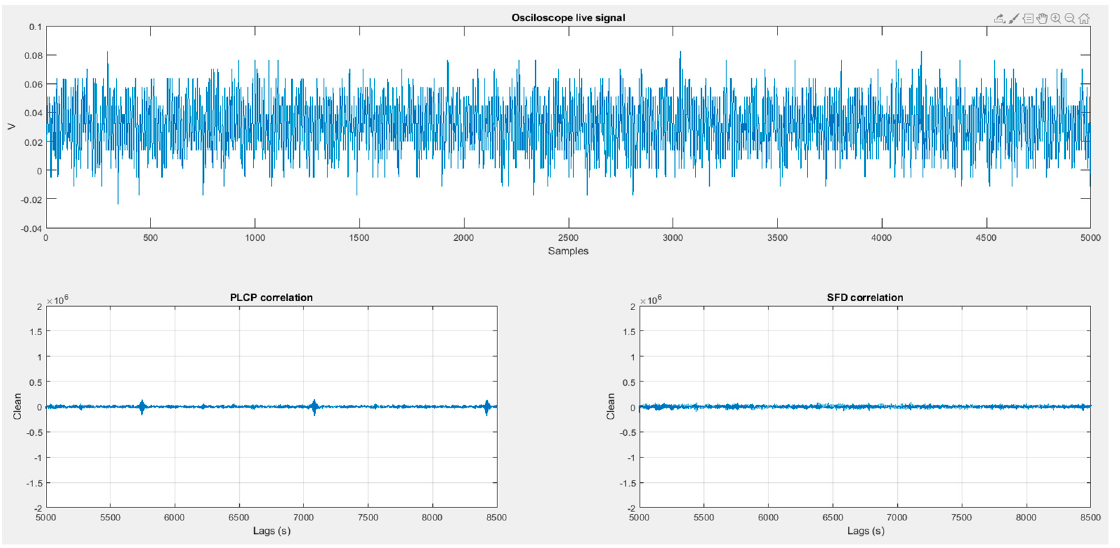
Figure 10. No contact situation.